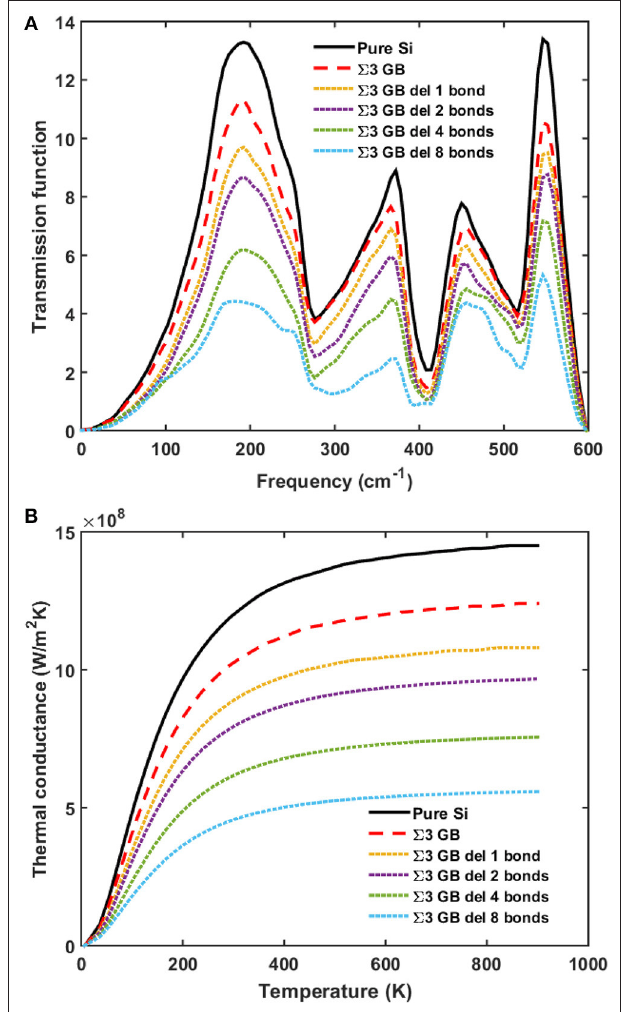
FIGURE 3 | (A) Phonon transmission and (B) thermal conductance for pure silicon (black solid line), silicon with perfect 6 3 grain boundary (red dashed line), and silicon with defective 6 3 grain boundary with dangling bonds (dotted